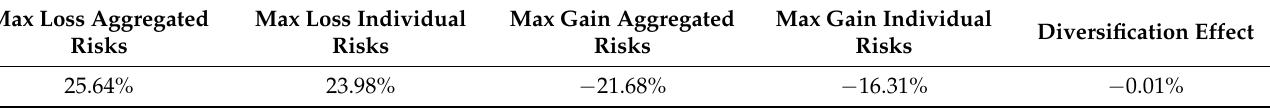
Table 10. Diversification effects of investing in a cryptocurrency portfolio.